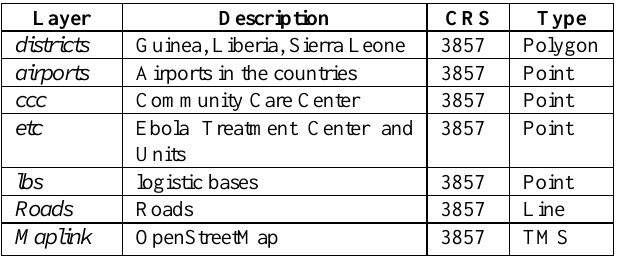
Table 2. Metadata of Ebola dataset